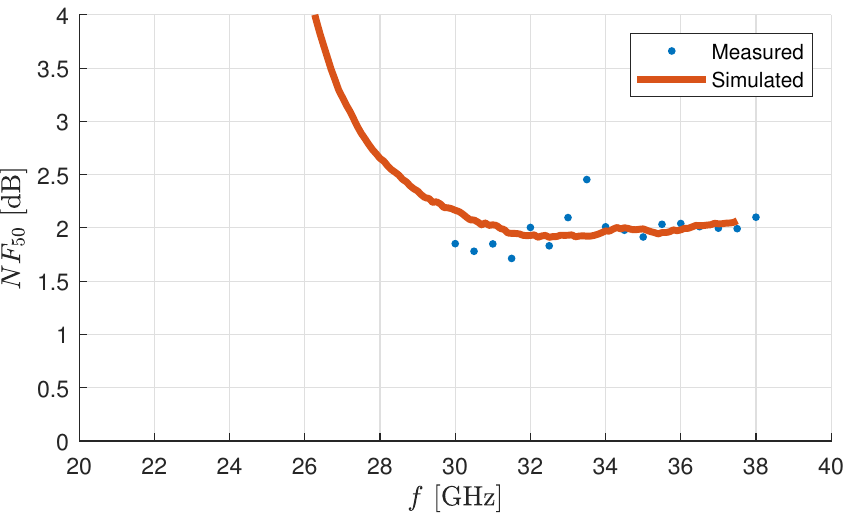
Figure 7. Noise figure of the mixed-technology LNA from [22]. The measurement refers to the actual, realized amplifier. The simulation is obtained by using the black-box characterization to simulate the first stage. The other stages are in the 100 nm technology and maintain their previous